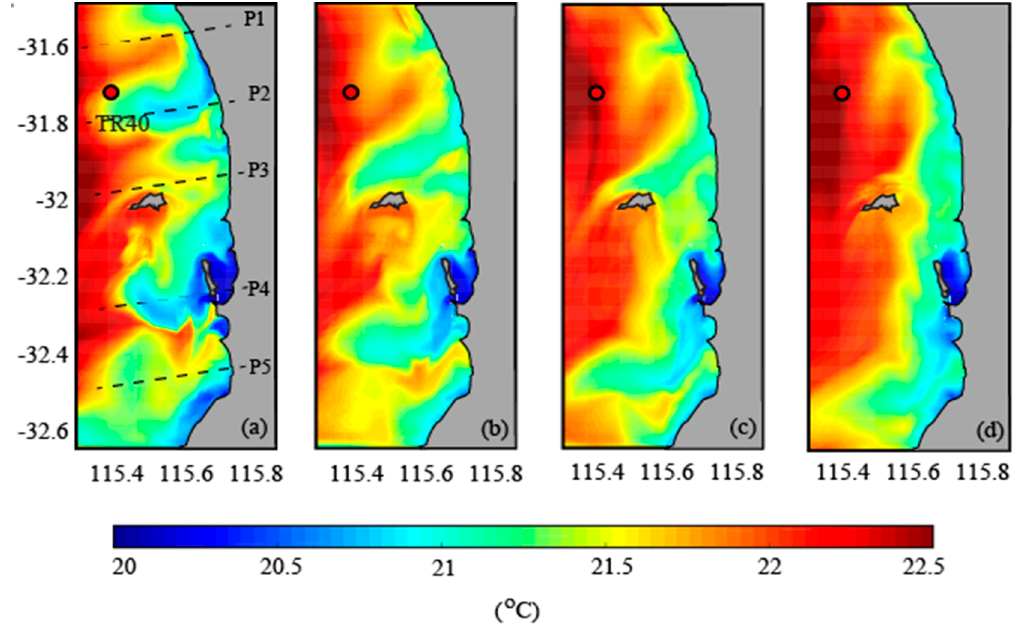
Figure 8. Distribution of daily mean bottom temperature showing the spatial and temporal variability of cold water plumes from model output during low to moderate wind conditions (1–10 ms − 1 ): ( a ) May 13, 2016; ( b ) May 14, 2016; ( c ) May 15, 2016; and ( d ) May 16, 2016. P1, P2, P3, P4, and P5 were defined as five different DSWC pathways.